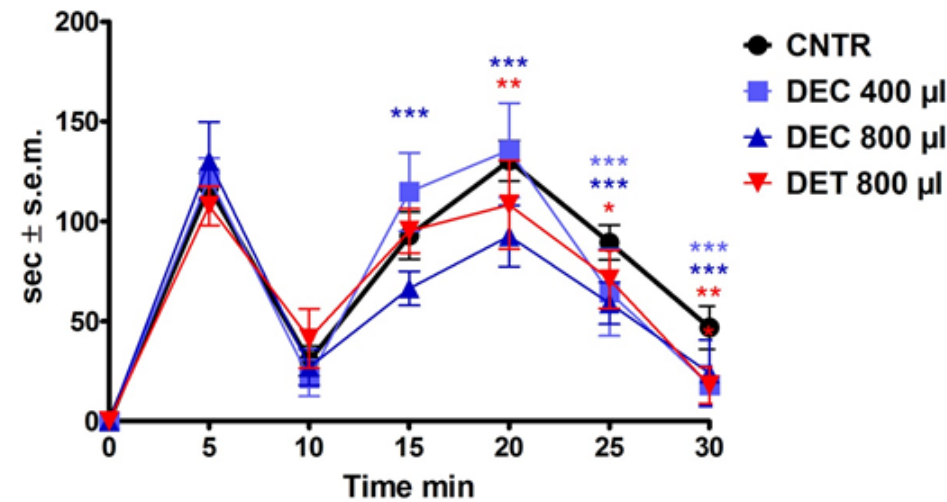
Figure 4. Effects of bergamot essential oil (BEO) and of its decolored (DEC) and deterpenated (DET) fractions on 2% formalin-induced licking/biting behavior expressed in seconds (sec). Two-way ANOVA followed by Bonferroni test; n = 8, * p < 0.05, ** p < 0.01, *** p < 0.001.